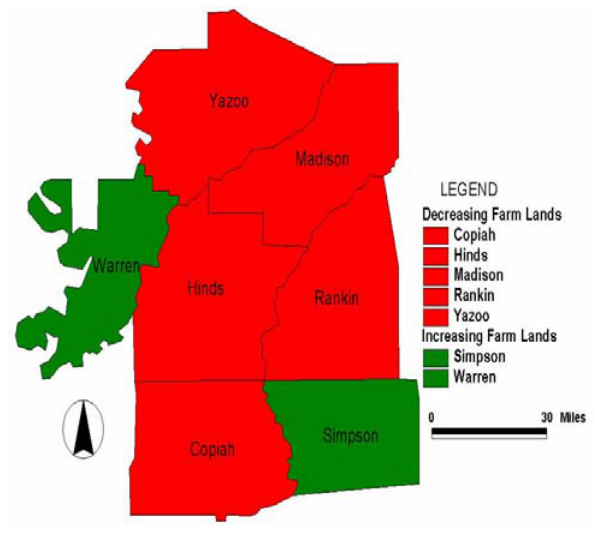
Figure 2.2 : Counties with Increasing and Decreasing Farm Lands from 1987-1992